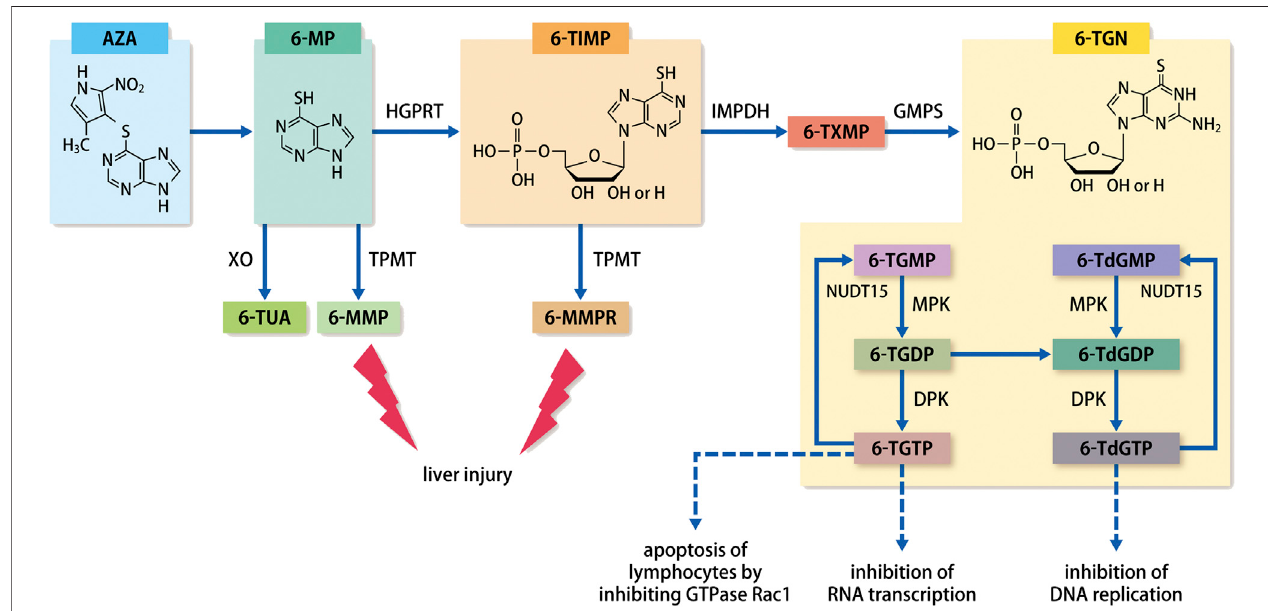
FIGURE 1 | Metabolic pathways of thiopurines. Abbreviation:AZA,azathioprine;6-MP,6-mercaptopurine;6-MMP,6-methylmercaptopurine;6-TUA,6-thiouricacid;6-TIMP,6-thioinosinemonophosphate;6-MMPR, 6-methylmercaptopurine ribonucleotides; 6-TXMP, 6-thioxanthosine monophosphate; 6-TGN, 6-thioguanine nucleotides; 6-TGMP, 6-thioguanosine monophosphate; 6-TGDP, 6-thioguanosine diphosphate; 6-TGTP, 6-thioguanosine triphosphate; 6-TdGMP, 6-thio-deoxyguanosine monophosphate; 6-TdGDP, 6-thio-deoxyguanosine diphosphate; 6-TdGTP, 6-thio-deoxyguanosine triphosphate; TPMT, thiopurine S-methyltransferase; XO, xanthine oxidase; HGPRT, hypoxanthine guanosine phosphoribosyl transferase; IMPDH, inosine monophosphate dehydrogenase; GMPS, guanosine-monophosphate synthetase; MPK, monophosphate kinase; DPL, diphosphate kinase; NUDT15, Nudix hydrolase